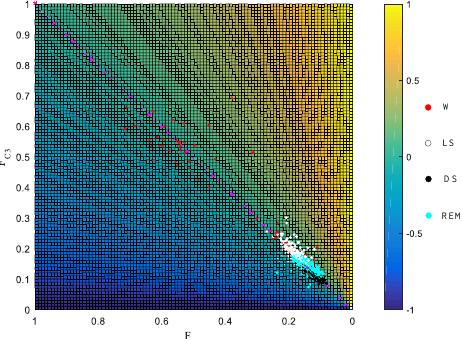
Figure 6. LI distribution for different sleep states.